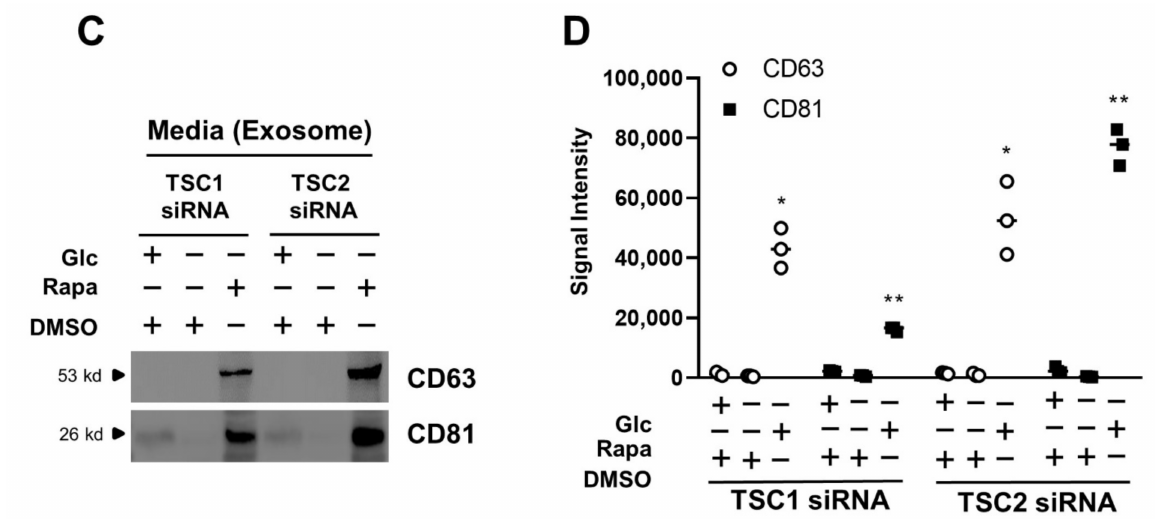
Figure 3. Exosome release is enhanced by mTORC1 inhibition in TSC1- or TSC2-silencing cells. ( A ) HEK293 cells transfected with either TSC1 siRNA or TSC2 siRNA were cultured with completed media, and then incubated in the absence or presence of glucose for 48 h during serum starvation. The cells incubated in the absence of glucose were treated with 100 nM rapamycin for 24 h. The cells were harvested and lysed, and analyzed by immunoblotting with the indicated antibodies. pACC was used as a marker for glucose deprivation. pS6K was used as an indicator of mTORC1 activity for rapamycin treatment. Actin was used as a loading control. ( B ) The dot plot graph was quantified from three independent immunoblotting data. The CD63, and CD81 are exosome marker proteins. The quantification was performed with UN-SCAN-IT gel program. There are significant differences between − Glc and − Glc + Rapa treatment groups. * p = 0.00952 for CD63 and ** p = 0.00625 for CD81 in TSC1 siRNA, * p = 0.00010 for CD63 and ** p = 0.00007 for CD81 in TSC2 siRNA. ( C ) HEK293 cells transfected with either TSC1 siRNA or TSC2 siRNA were cultured with completed media, and then incubated in the absence or presence of glucose for 48 h during serum starvation. After the collection of medium from cells, the media were subjected to ultracentrifugation to harvest the exosome fraction, according to the materials and methods. The samples were analyzed by immunoblotting with antibodies for exosome marker proteins, such as CD63, and CD81. ( D ) The dot plot graph was quantified from three independent immunoblotting data. Quantification of the data of CD63 and CD81 was performed with UN-SCAN-IT gel program. There are significant differences between − Glc and − Glc + Rapa treatment groups. * p = 0.00001 for CD63 and ** p = 0.00625 for CD81 in TSC1 siRNA, * p = 0.00179 for CD63 and ** p = 0.00003 for CD81 in TSC2 siRNA. Glc: Glucose, Rapa: Rapamycin, DMSO: Dimethyl